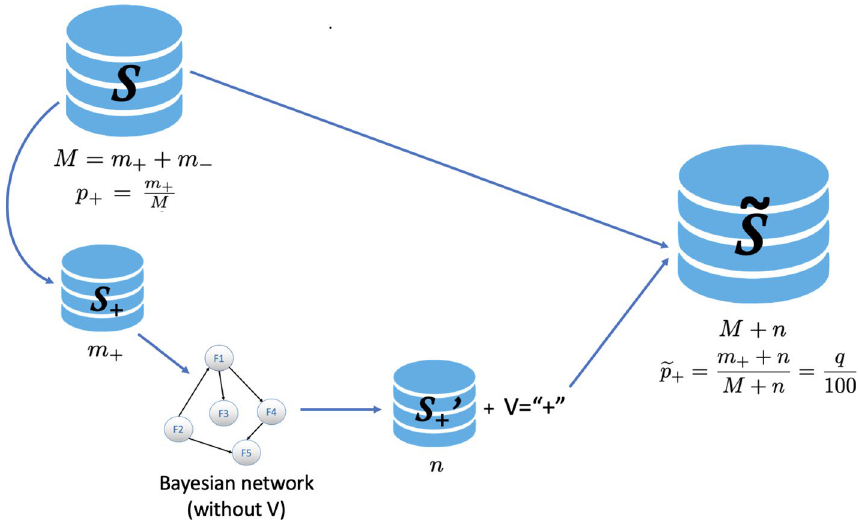
Figure 1. Graphical scheme of the BOSME